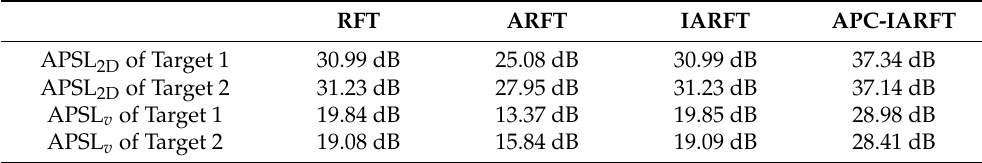
Figure 13. Velocity-dimension output of four methods in Scenario 3. Table 6. APSL 2D and APSL v of the targets set in Scenario 3.